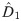
Spectral diastances contrast D^1—For the three matrices: Adjacency, combinatorial Laplacian, and normalized Laplacian (from left to right)—Between the small-world graph and the degree matched configuration model (null model).